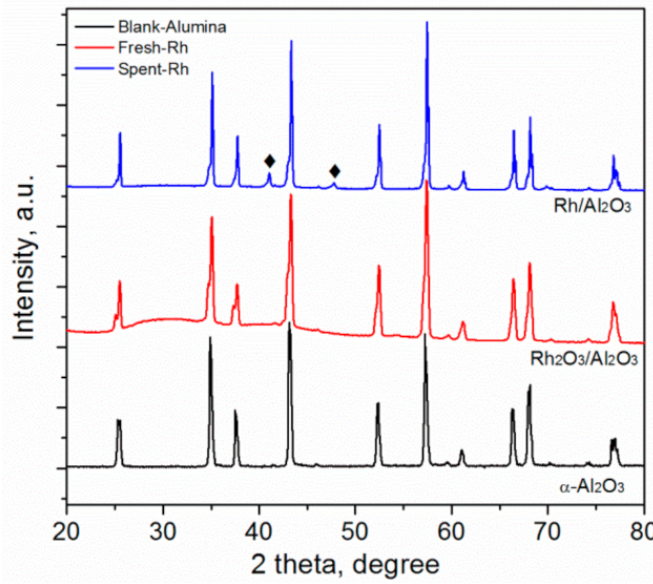
Figure 8. XRD patterns of a blank α -Al 2 O 3 , fresh and spent Rh/Al 2 O 3 samples ( (cid:7) : metallic